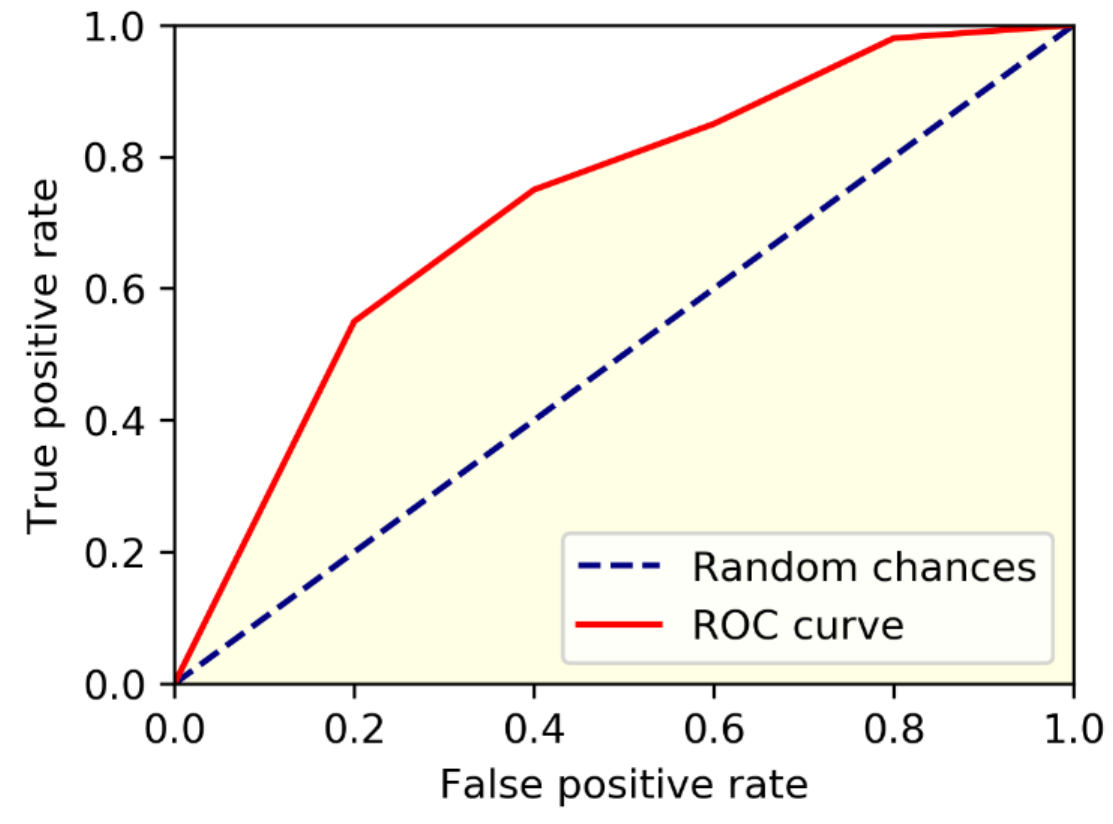
Figure 11. ROC analysis of the proposed model.